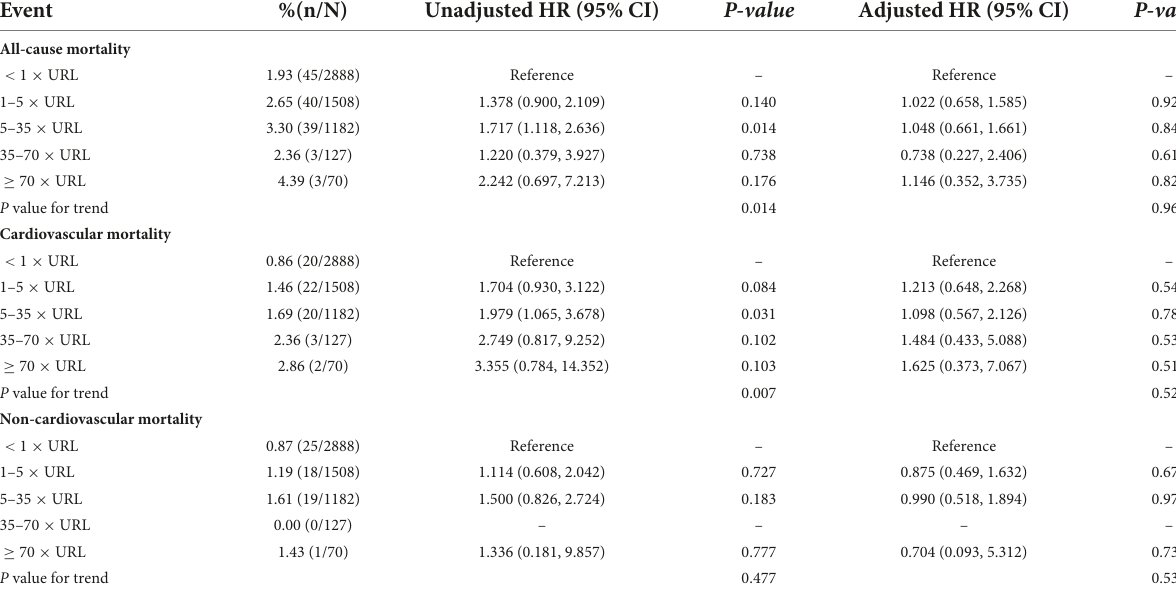
TABLE 2 Hazard ratios for 3-year mortality with different thresholds of post-PCI peak cTn values. Event %(n/N) Unadjusted HR (95% CI) P-value Adjusted HR (95% CI)